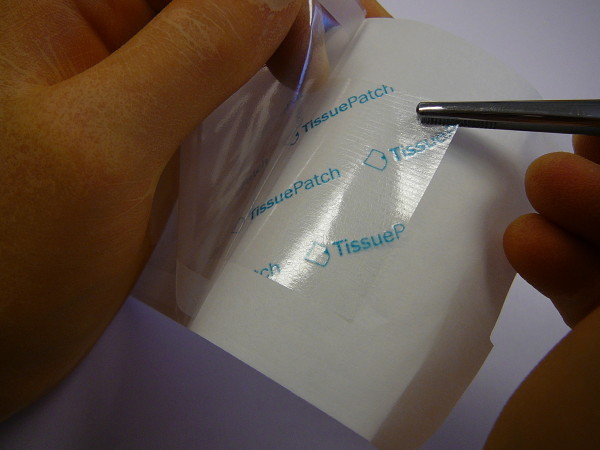
TissuePatchTMsynthetic sealant film.